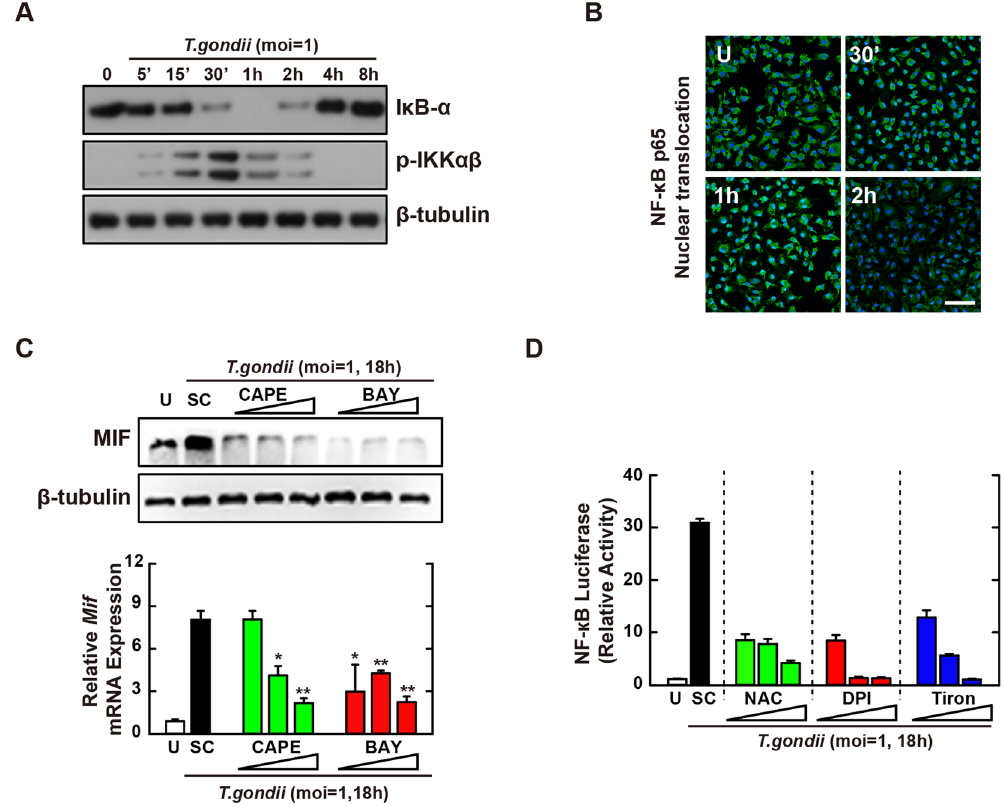
Figure 3. NF- κ B signaling plays an essential role in T . gondii -induced MIF expression by BMDMs. ( A , B ) BMDMs were infected with T . gondii RH strain (moi = 1) for the indicated time periods. ( A ) Immunoblot analysis was performed to determine protein expression of total I κ B- α and phosphorylated IKK α / β . β -tubulin served as a loading control. ( B ) Immunofluorescence analyses of NF- κ B p65 nuclear translocation. Cells were fixed and stained with anti-NF- κ B p65 (green); nuclei were stained with DNA-intercalating dye DAPI (blue). Scale bar = 50 μ m. ( C ) BMDMs were pretreated with CAPE (1, 5 or 10 µ M, 2 h) and BAY (0.1, 1, 3 μ M, 45 min) and then infected with T . gondii RH strain (moi = 1) for 18 h. Immunoblot (top) or qPCR (bottom) analysis was performed to determine protein and mRNA expression MIF, respectively. ( D ) Raw 264.7 cells were transfected with plasmids carrying NF- κ B luciferase reporter constructs. Cells were pretreated with general antioxidant (NAC; 1, 2, or 5 mM), Nox inhibitor (DPI; 1, 5, or 10 μ M) or superoxide scavenger (Tiron; 5, 10, or 20 mM) and then infected with T . gondii RH strain (moi = 1) for 18 h. Luciferase activity were measured and normalized to β -galactosidase activity. Data are representative of three independent experiments and are presented as means ± SD. * P < 0.05, ** P < 0.01, *** P < 0.001, two-tailed Student’s